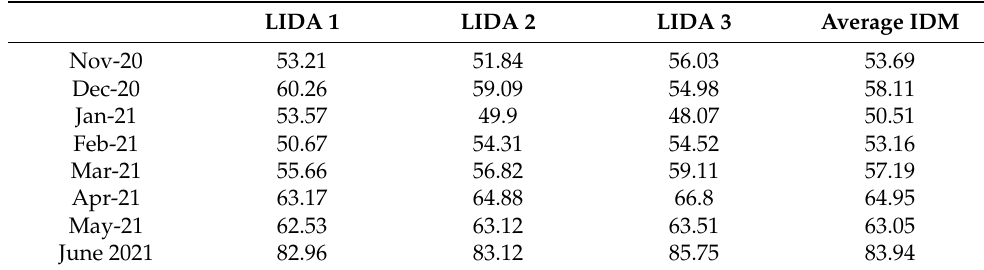
Energy Exchange and Authors’